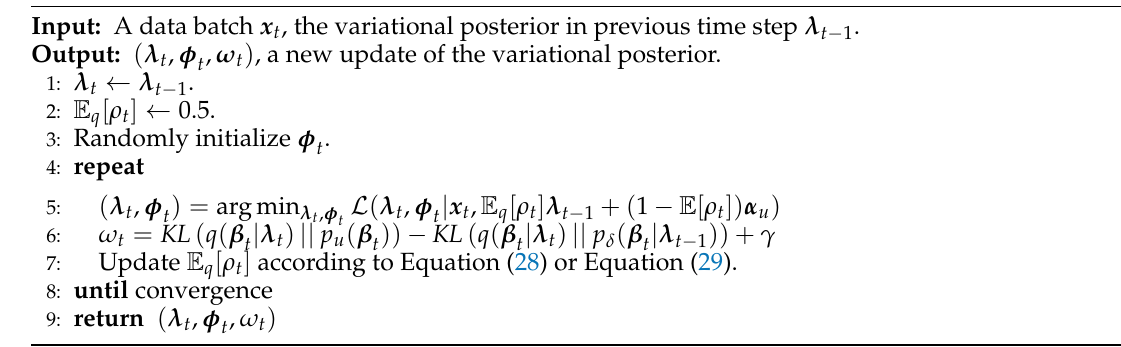
Algorithm 1 Streaming variational Bayes (SVB) with Hierarchical Power Priors